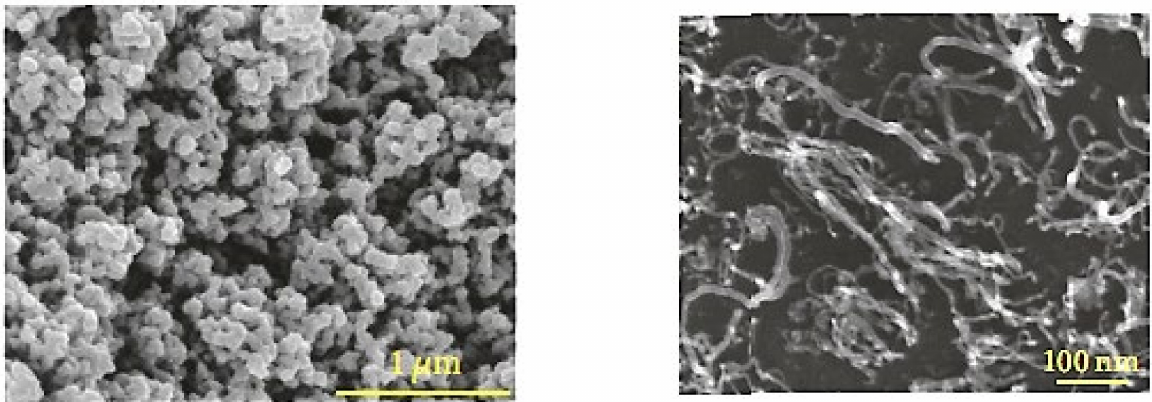
Figure 2. Carbon nanostructure growth, ( Left ) Spherical structures, ( Right ) Tubular structure. Adapted with permission from Ref.